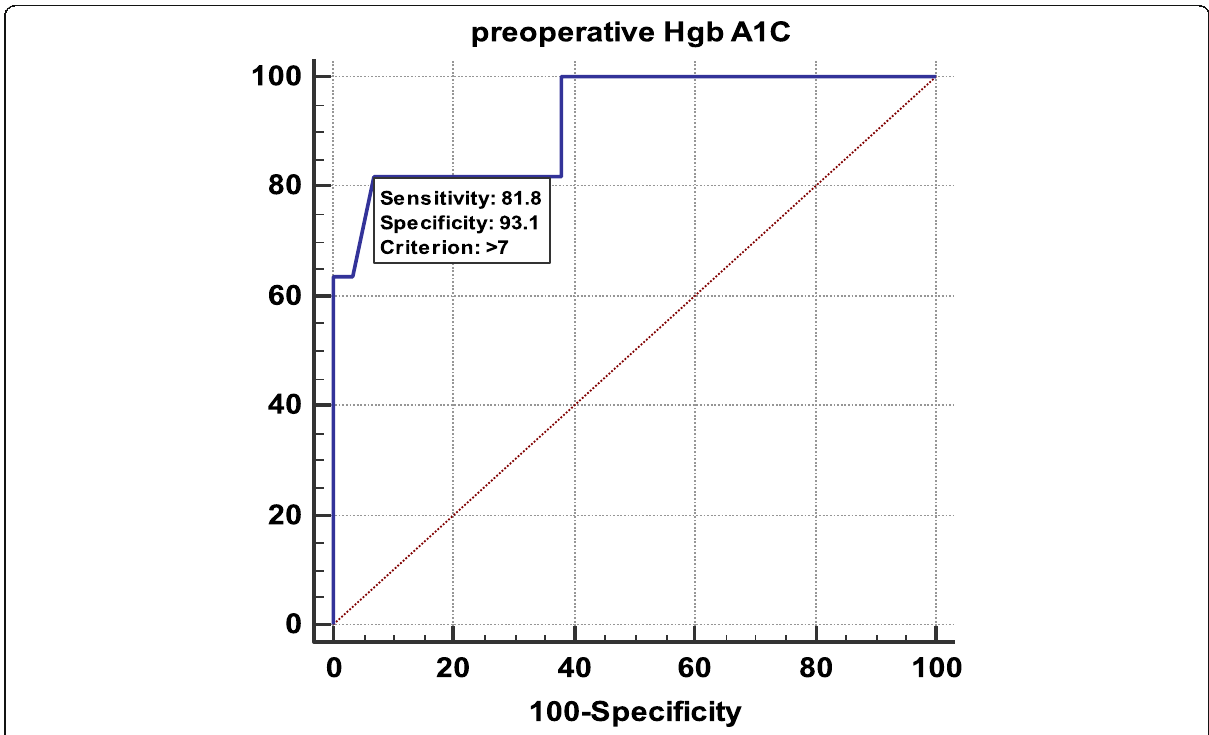
Fig. 1 ROC curve for Hgb A1C and incidence of